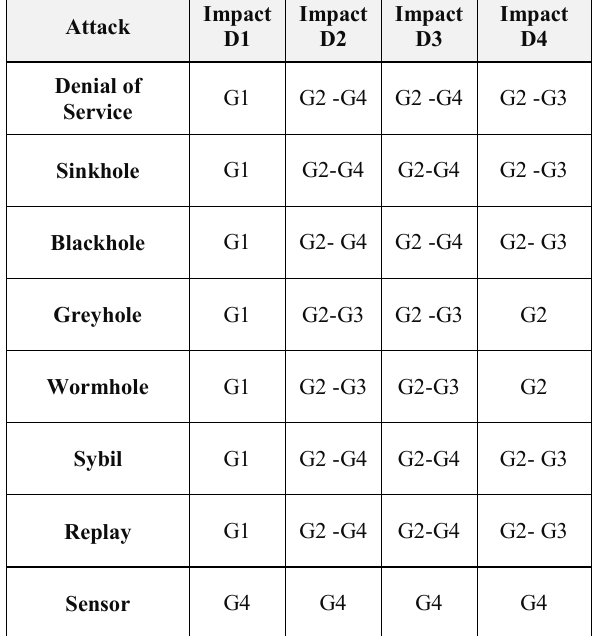
Table 4. The proposed impact evaluation based on the application